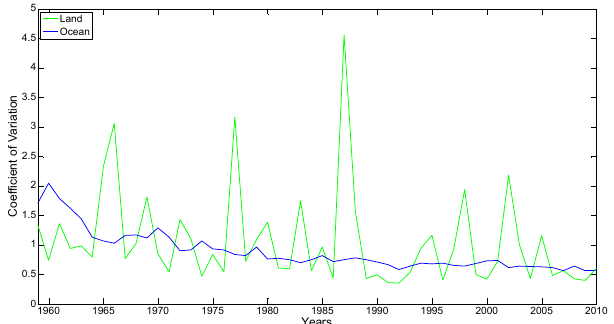
Figure 11. Proportion of error in terms contributing to the global carbon uptake. The total error in global C uptake is calculated as the square root sum of squared standard deviations for each term in the global budget (black line). The proportion of global C uptake un- certainty contributed from land use (green area) has remained fairly constant, the proportion of global C uptake uncertainty contributed from fossil fuels (red area) has risen in recent years, and the propor- tion of global C uptake uncertainty contributed from atmospheric CO 2 measurements (blue area) has